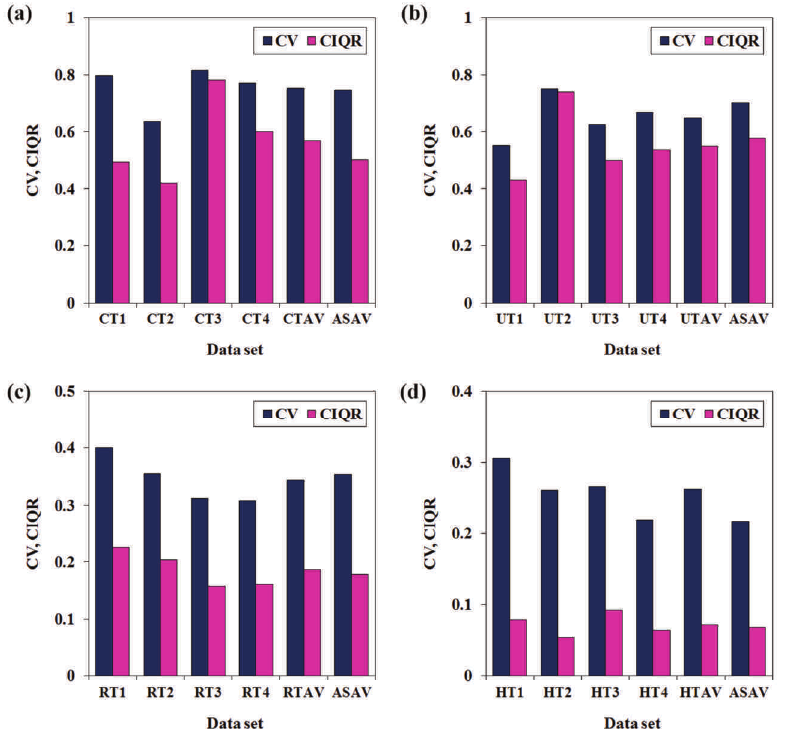
Fig. 4. Coefficient of variation (CV) and the coefficient of interquartile range (CIQR) for the velocity process realizations in individual driving test cycles, in sets of four test cycles of the same category, and in all the velocity samples collected: a) urban traffic congestions (CT); b) urban traffic (UT);